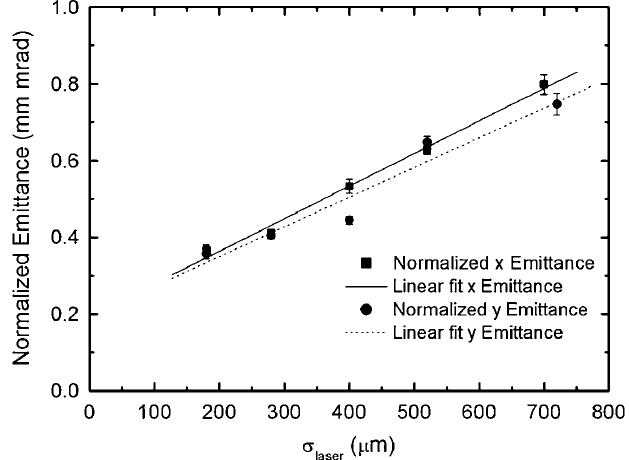
FIG. 8. SEM micrograph of the Mg film over the Cu back- flange after the removal from the rf gun: the white dashed line evidences the border of the Mg film. Several damaged areas are also clearly evident.